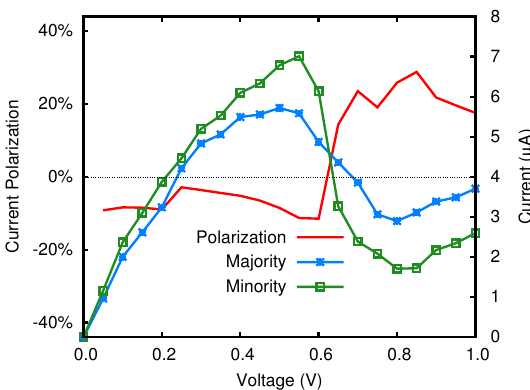
Figure 8. I ( V ) curve in the FeP nanojunction with N-doped electrodes.